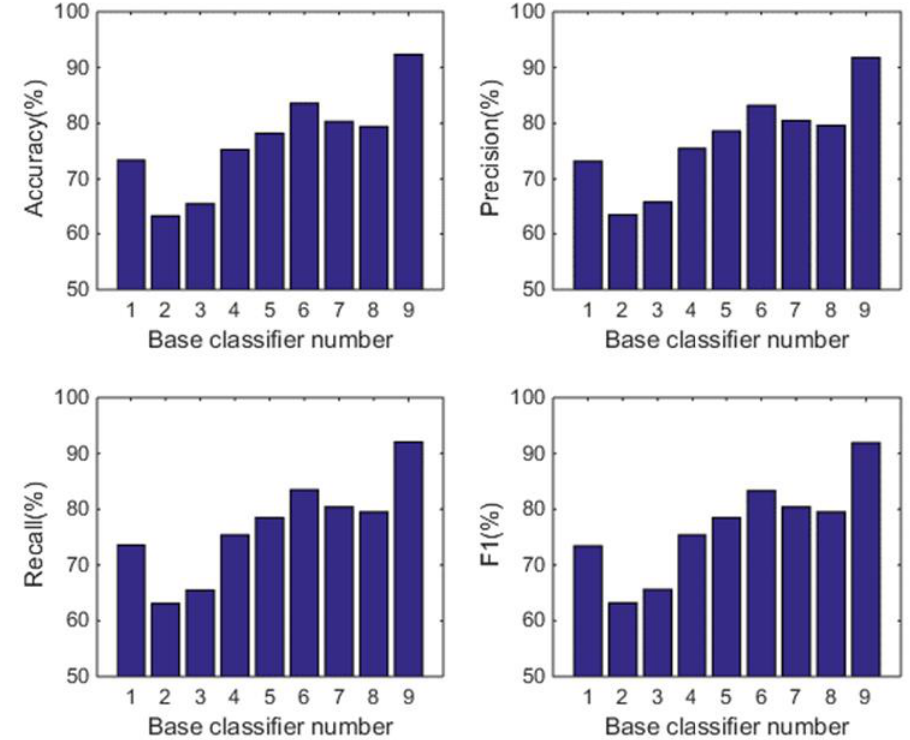
Figure 7. Performance comparison between base classifiers (1–8) and our fused classifier (9) for subject 4 in OPPORTUNITY dataset.